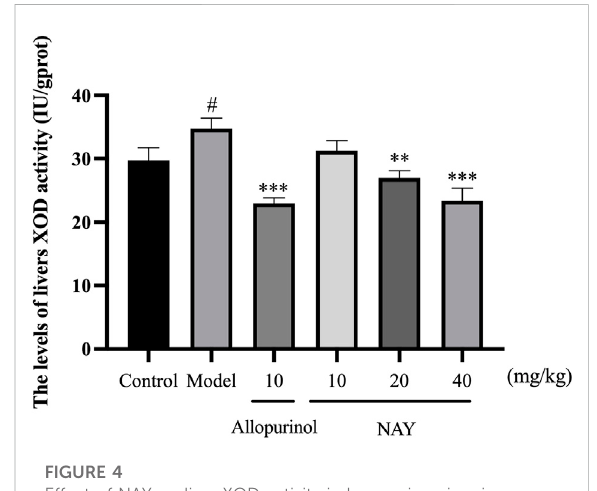
FIGURE 4 Effect of NAY on liver XOD activity in hyperuricemia mice. (Data were expressed as mean ± S.E.M.; n = 8. Compared with the control group, # p < 0.05, ## p < 0.01, and ### p < 0.001. Compared with the model group, * p < 0.05, ** p < 0.01, and *** p <